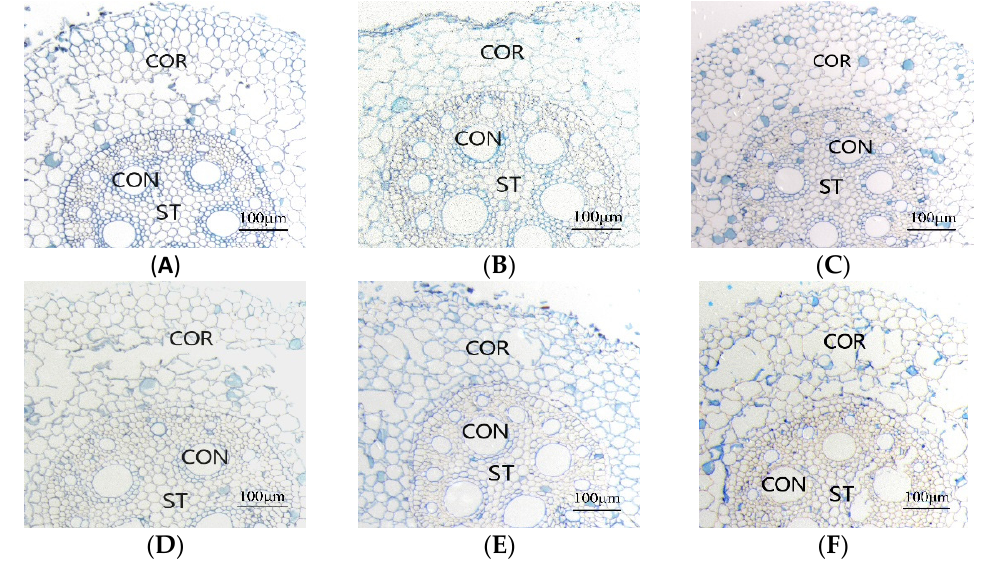
Figure 3. Effects of different root zone temperatures on the root microstructure of SD609 and